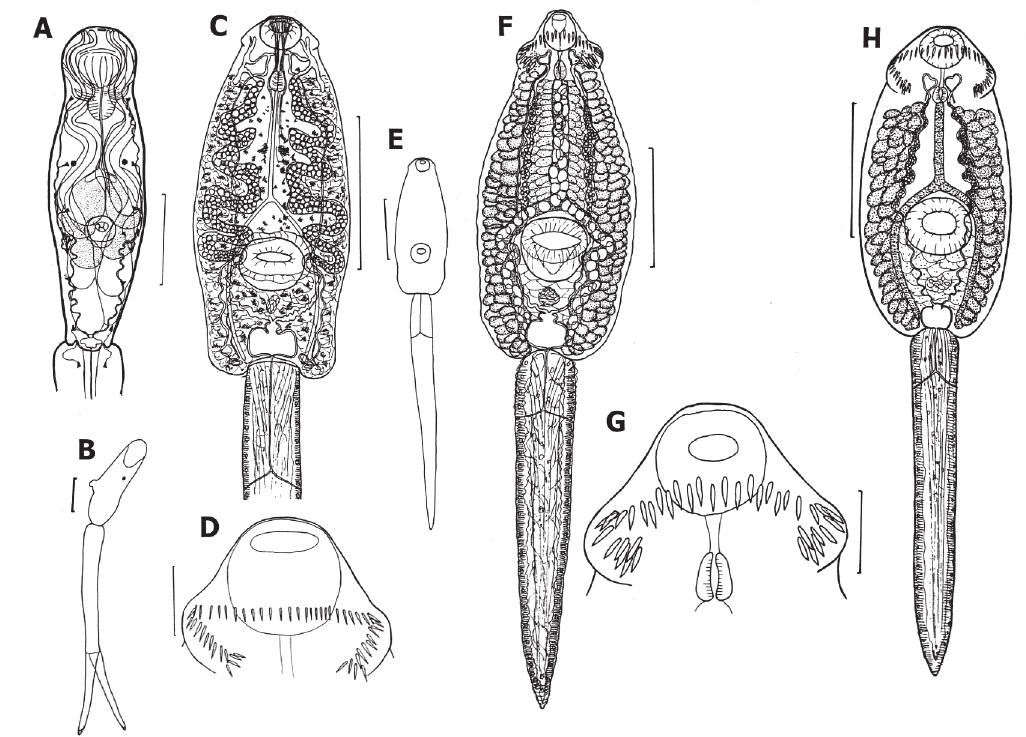
Fig. 3. – Trichobilharzia szidati (A, B); Cathaemasia hians (C, D, E); Echinoparyphium aconiatum (F, G); Echinoparyphium recurva- tum (H); A, C – detail of body, scale bars: A – 100 µm, C – 200 µm; B, E, F, H – whole cercaria, scale bars: B, H – 100 µm, E, F – 200 µm; G, D – detail of anterior part with collar spines, scale bar: 50